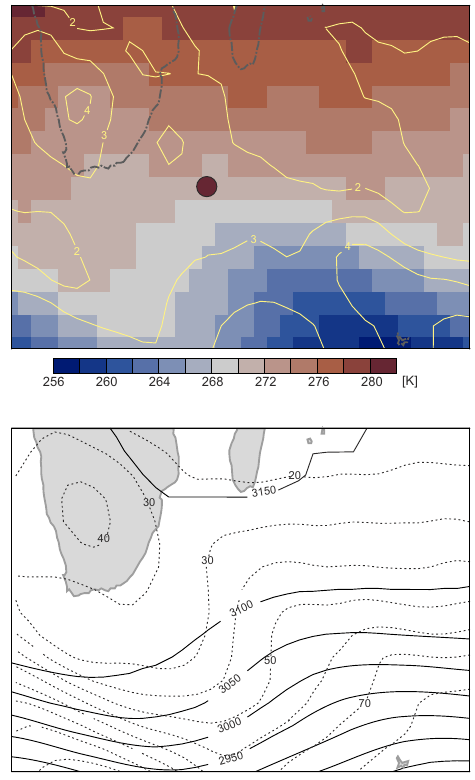
Fig. 3. Data from 20CR at 700hPa on 18 May 1906, 12:00UTC. Top: ensemble mean temperature (colours) and ensemble spread (yellow lines). The large circle indicates the location and value of the observed temperature onboard SMS Planet (ascent number 22). Bottom: ensemble mean GPH (solid lines) and ensemble spread (dashed). The area displayed is (20 ◦ S–50 ◦ S, 10 ◦ E–80 ◦